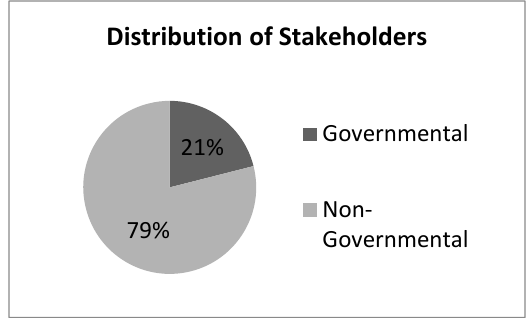
Figure 1. Stakeholder distribution Table 1. Professional titles of stakeholders